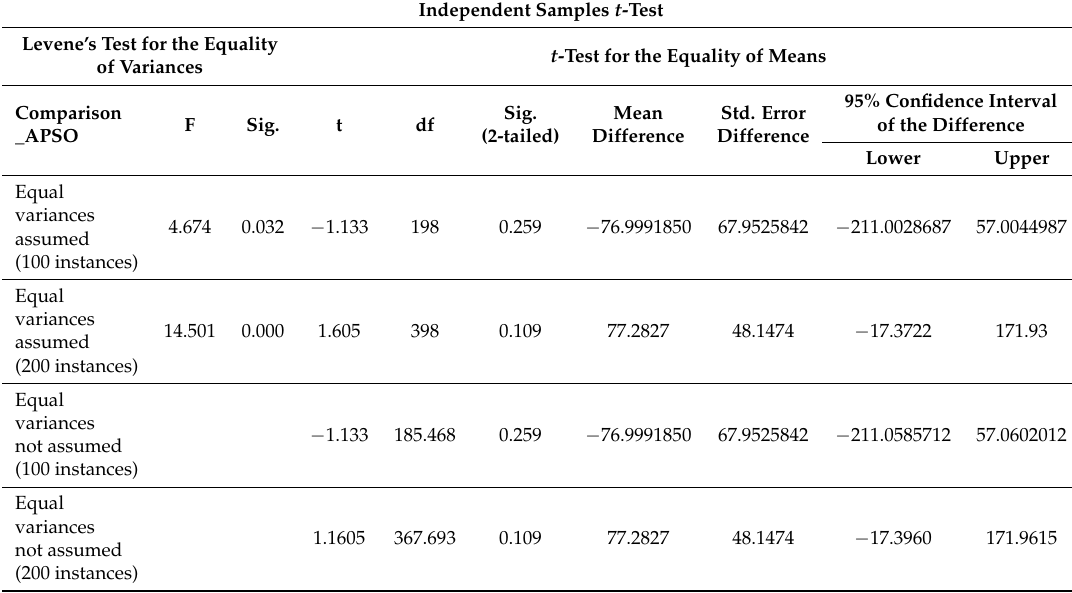
Table 7. SPSS results of the independent sample t -test showing the comparison between simple APSO and improved APSO on the non-cascaded non-pumped STHTS problem. Independent Samples t -Test